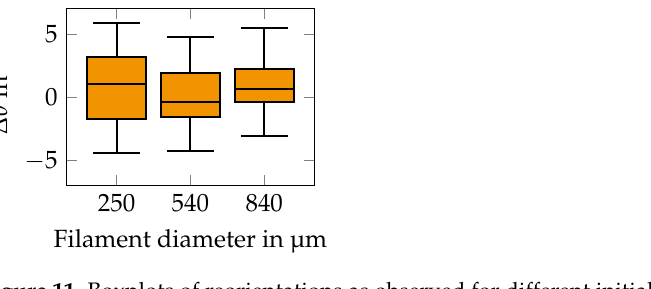
Figure 11. Boxplots of reorientations as observed for different initial filament